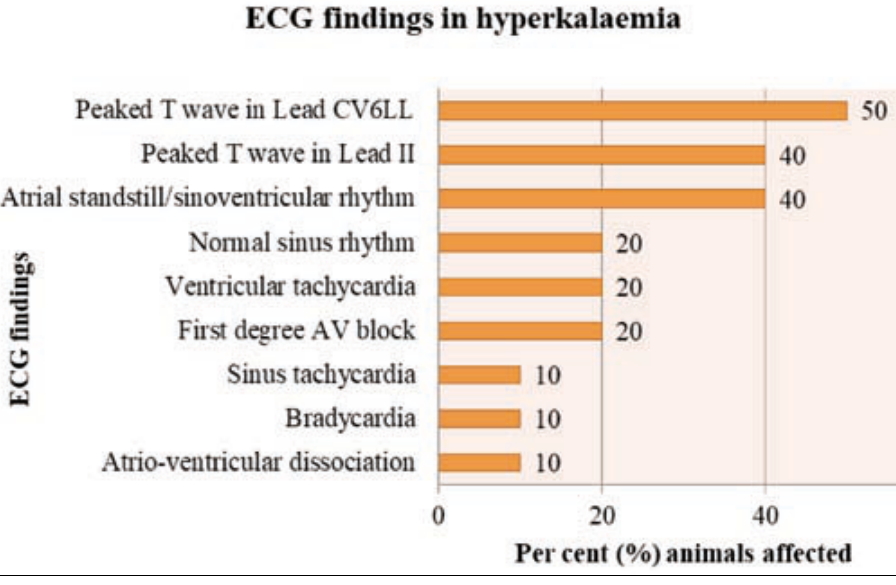
Fig. 2. Electrocardiographic findings associated with hyperkalaemia in